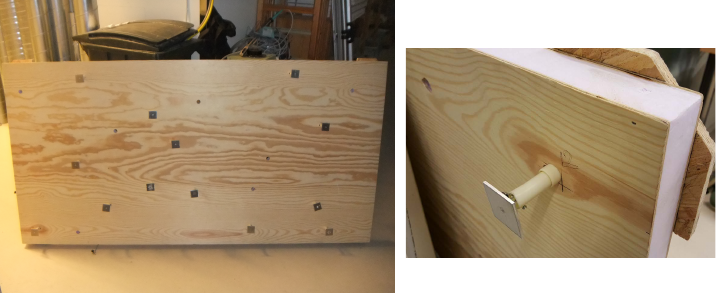
Figure 7. Left: the heating rig with individual heating devices. Right: close-up of a heating